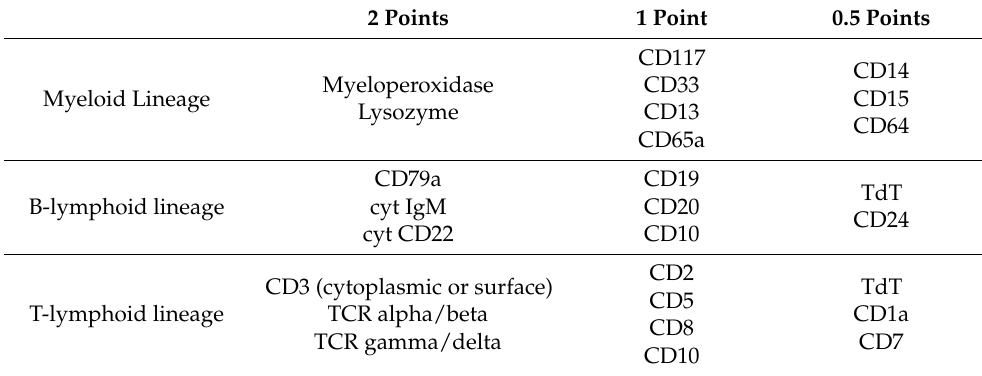
Table 1. European Group of Immunological Classification of Leukemia scoring system. 2 Points 1 Point Myeloperoxidase Myeloid Lineage